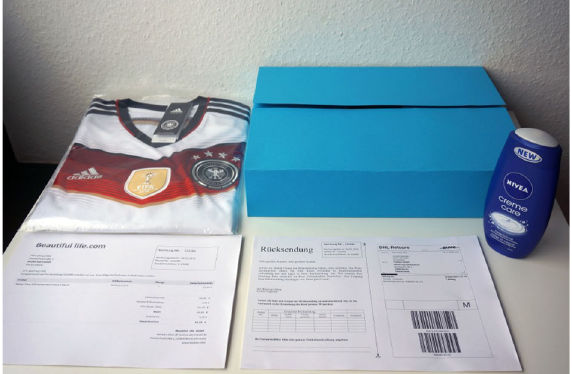
Fig. 3 Product and package stimuli in Study